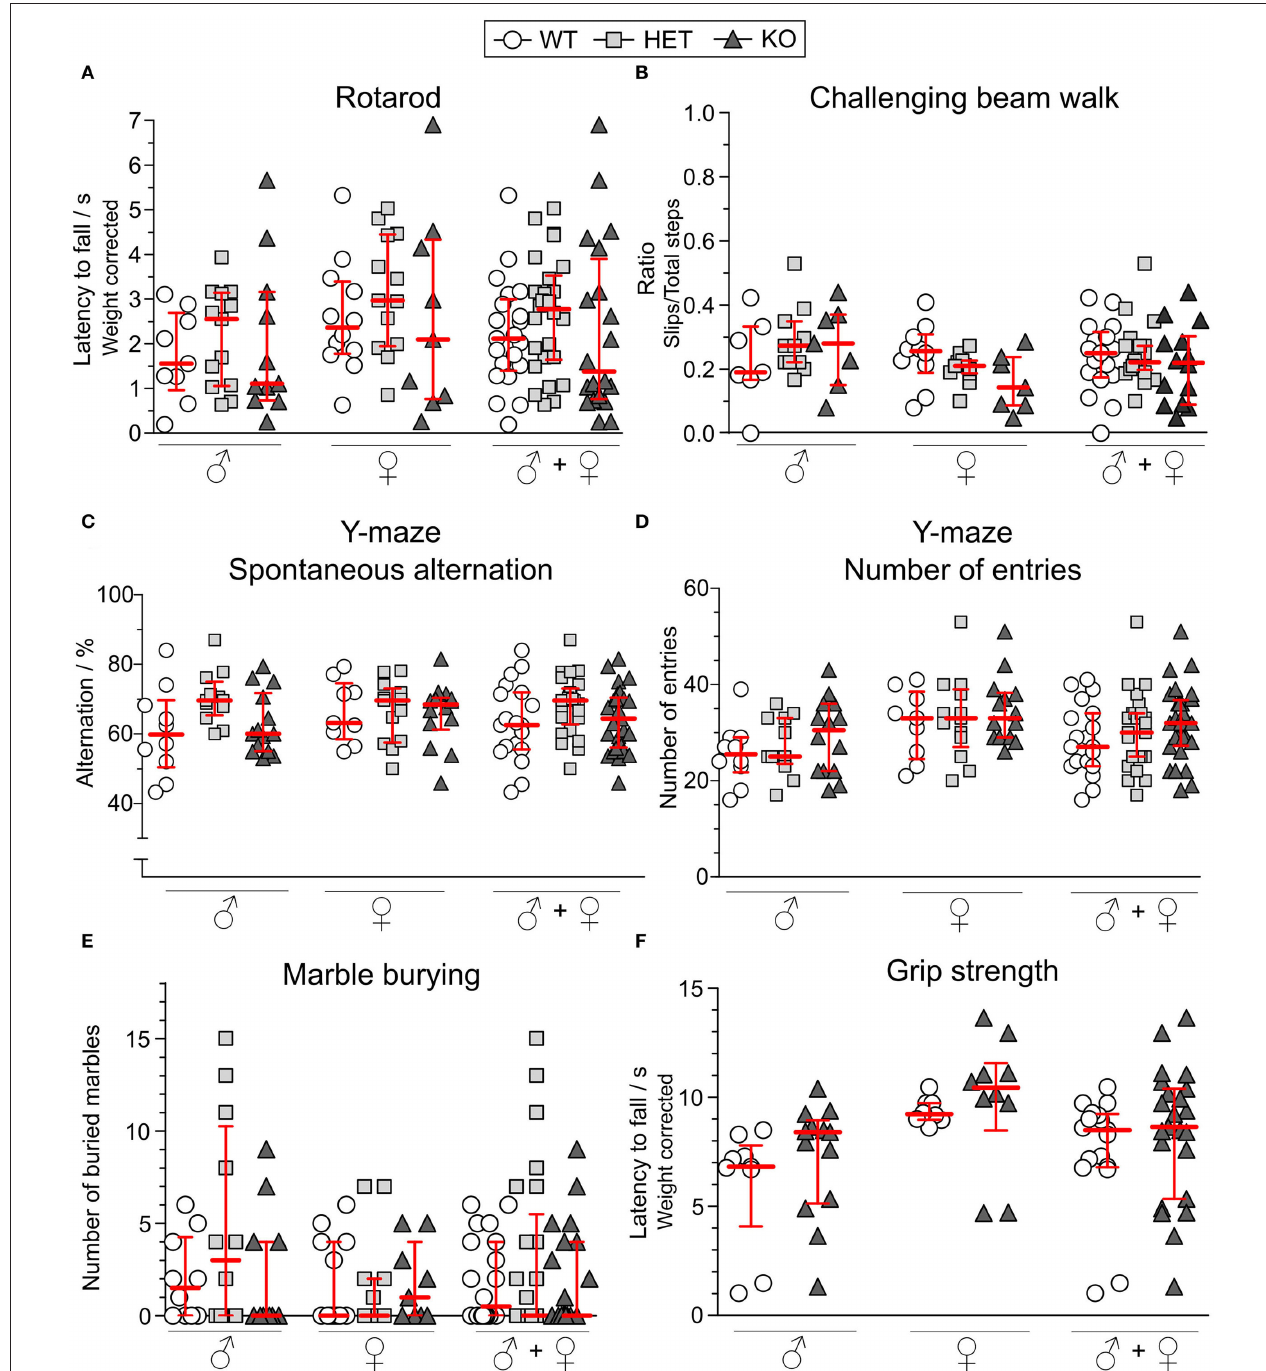
FIGURE 5 | Motor function, Y-maze behavior and marble burying are unaffected in SLC38A10-deficient mice. For studying the motor function, (A) the rotarod [ n (males) = 9 WT, 13 HET, 11 KO; n (females) = 12 WT, 13 HET, 9 KO] and (B) challenging beam walk [ n (males) = 7 WT, 11 HET, 7 KO; n (females) = 10 WT, 11 HET, 7 KO] tests were used. Prior to the test day, animals had 3 (rotarod) respecitve 2 (challenging beam walk) days of training. On the test day, animals had 3 trials, and the best trial was used in analysis. For the rotarod data, results were weight corrected. For the challenging beam walk, the slip ratio was calculated from slips with all paws and from total steps with the right forepaw of the mouse. In the Y-maze [ n (males) = 10 WT, 12 HET, 14 KO; n (females) = 9 WT, 13 HET, 14 KO], (C) spontaneous alternation and (D) number of entries were observed during 10min of exploring the maze. (E) In the marble burying test [ n (males) = 10 WT, 12 HET, 11 KO; n (females) = 12 WT, 13 HET, 9 KO], the mice were introduced to 18 marbles, and marbles buried to at least 75% were counted after 15min. (F) Weight-corrected results from the grip strength test [ n (males) = 9 WT, 13 KO; n (females) = 8 WT, 10 KO], where animals hang upside-down on a grid for a maximum of 3min. Results from these tests are shown for each sex separately and together and are presented as medians with interquartile range. The genotype did not affect the mice’s ability to perform in either of the tests. Analyses were made with the Kruskal–Wallis and Dunn’s multiple comparisons test.